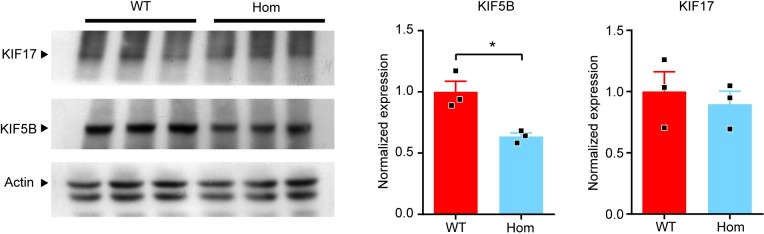
KIF5B conditional knockout mice show no change in KIF17 expression.Western blot analysis and quantification of KIF17 expression in total brain lysates of homozygous KIF5B conditional knockout mice (Hom) compared with control littermates (WT). n = 3 for WT. n = 3 for Homo. Data are presented in mean + SEM. *p<0.05, Mann-Whitney test.).
Figure 6—figure supplement 2—source data 1.Plotted values for Figure 6—figure supplement 2.